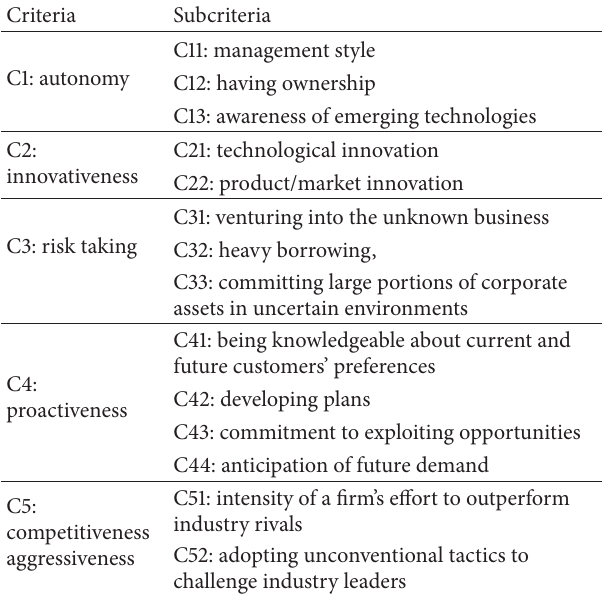
Table 2: Linguistic scales of